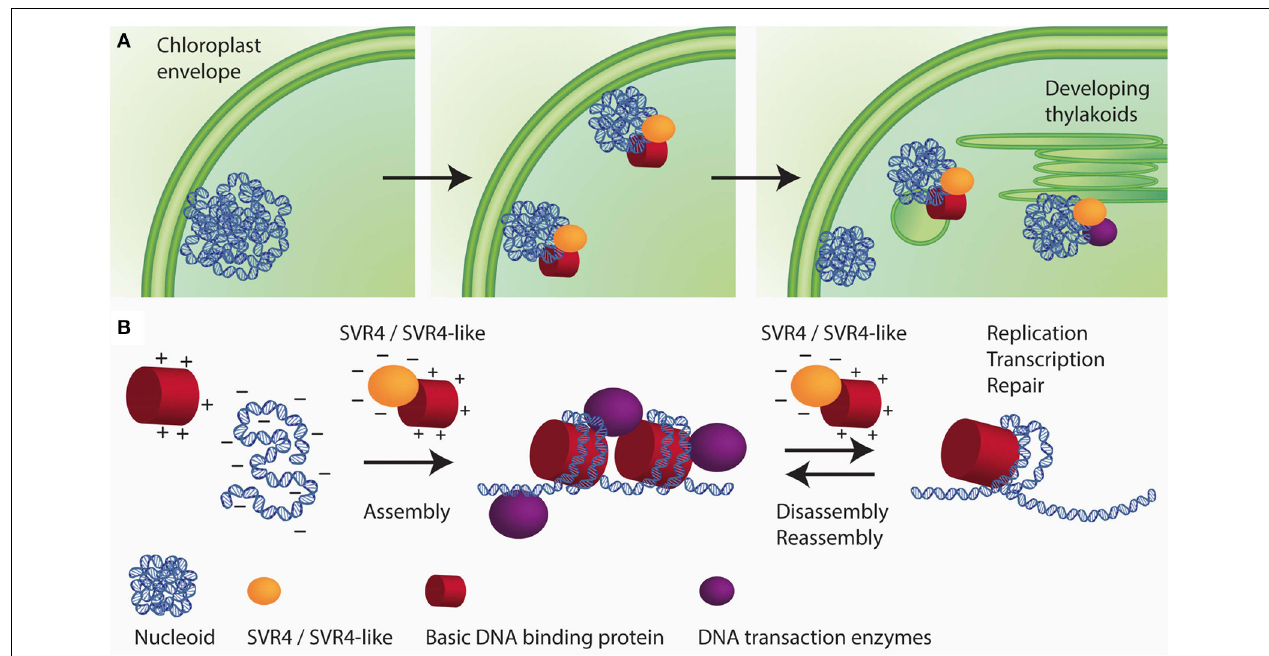
FIGURE 2 | Schematic drawing of SVR4/SVR4-like functioning as putative chaperones for ptNAPs during chloroplast development. (A) The spatial arrangement of plastid nucleoids dynamically changes in close relationship with the development of the inner membrane system of the plastids. During chloroplast development the nucleoids decrease in size but increase in number. The segregation process is thought to take place on the envelope membrane and eventually distribute to the thylakoids. (B) During